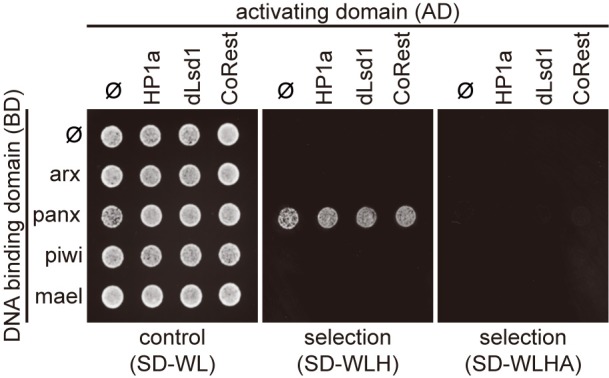
Protein interaction mapping among components of heterochromatin machinery by Y2H assay.Y2H assay to test the interaction between proteins that associated with Piwi/piRNAs complexes and proteins in the heterochromatin machinery. SD-WL, non-selective medium; SD-WLH and SD-WLHA, selective media. Ф, empty vector.